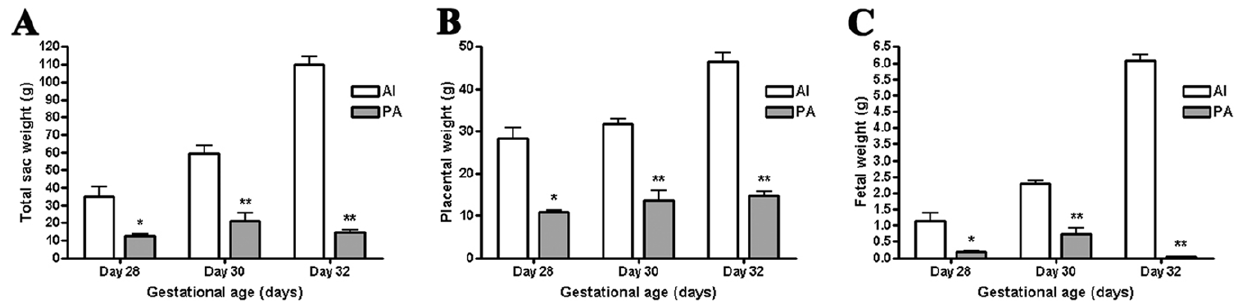
Figure 1. Comparison of fetal and placental growth in controls and canine parthenotes. Measured (A) total sac weight, (B) placental weight, and (C) fetal weights are shown as a function of gestational age. Data presented as mean 6 SEM of at least five replicates. *, ** Significant difference between the AI and PA groups at each gestational age ( * P , 0.05, ** P , 0.001). doi:10.1371/journal.pone.0041256.g001 PLOS ONE |